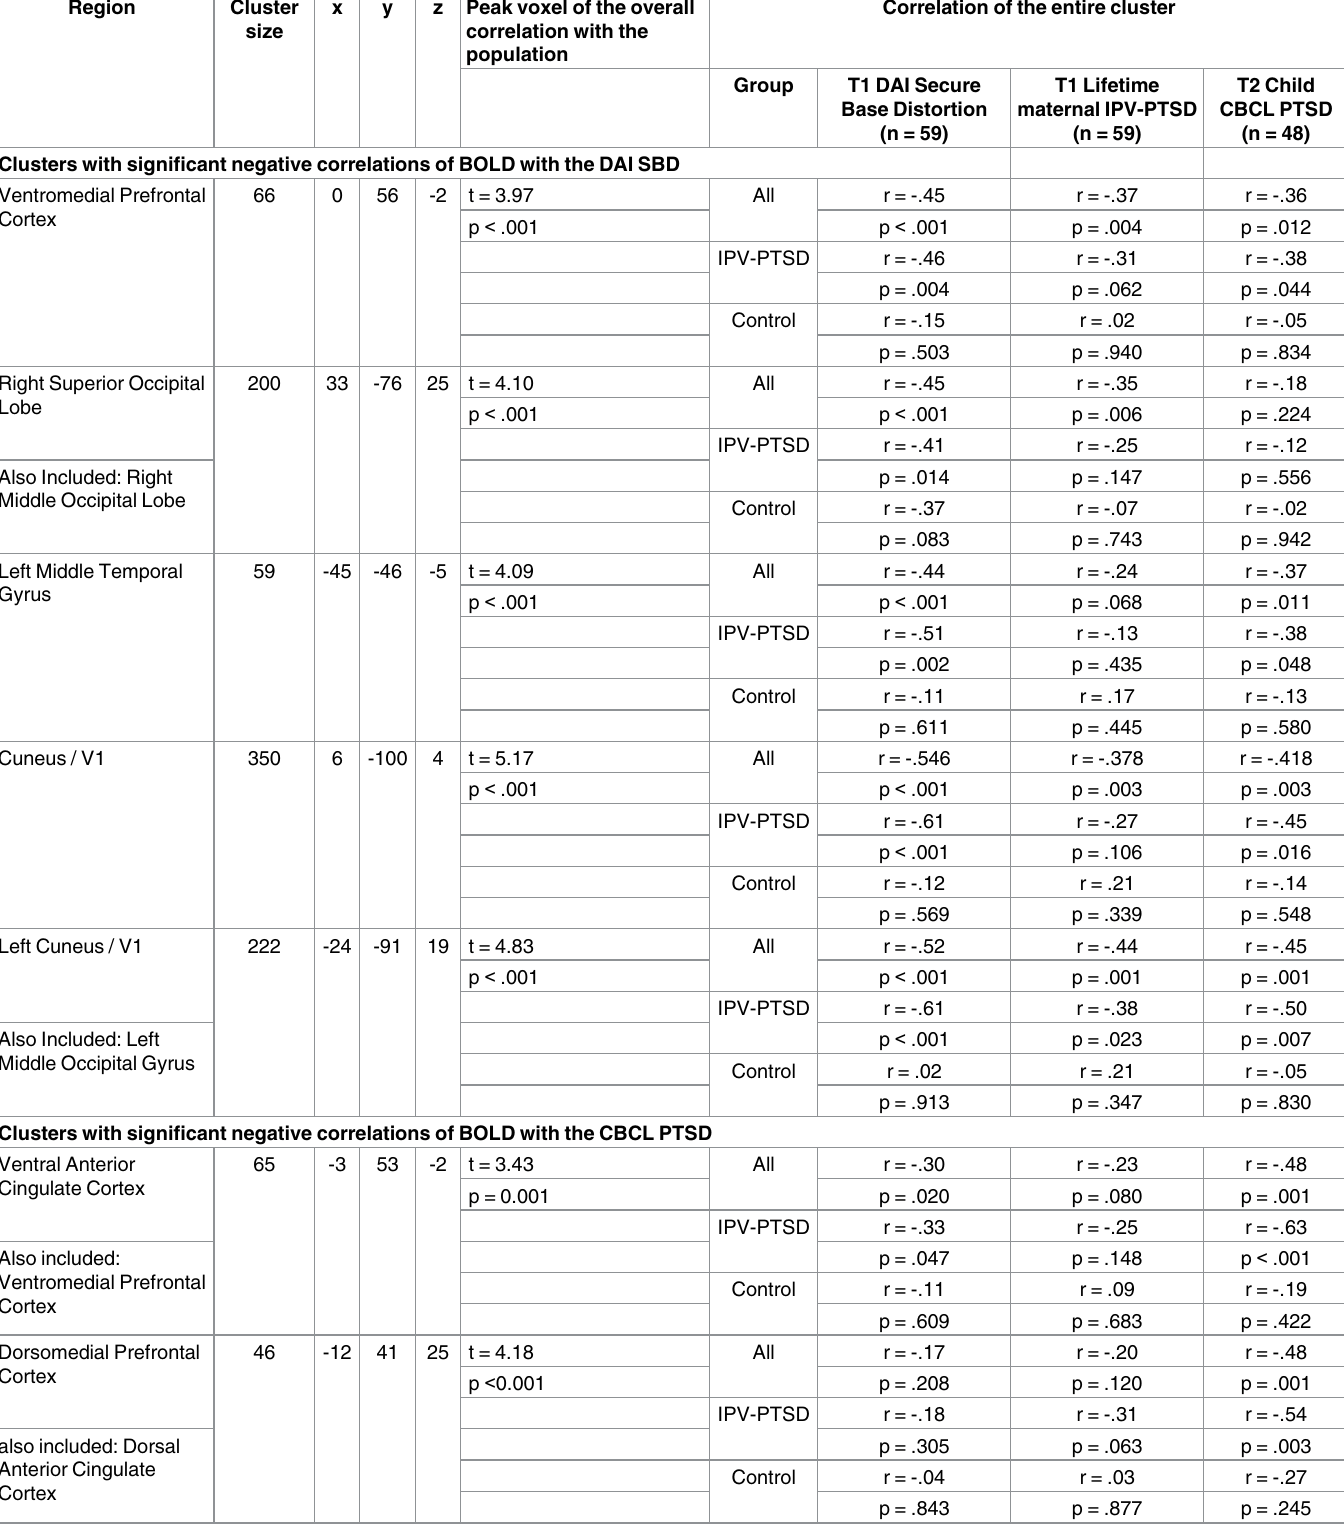
Correlation of the entire cluster